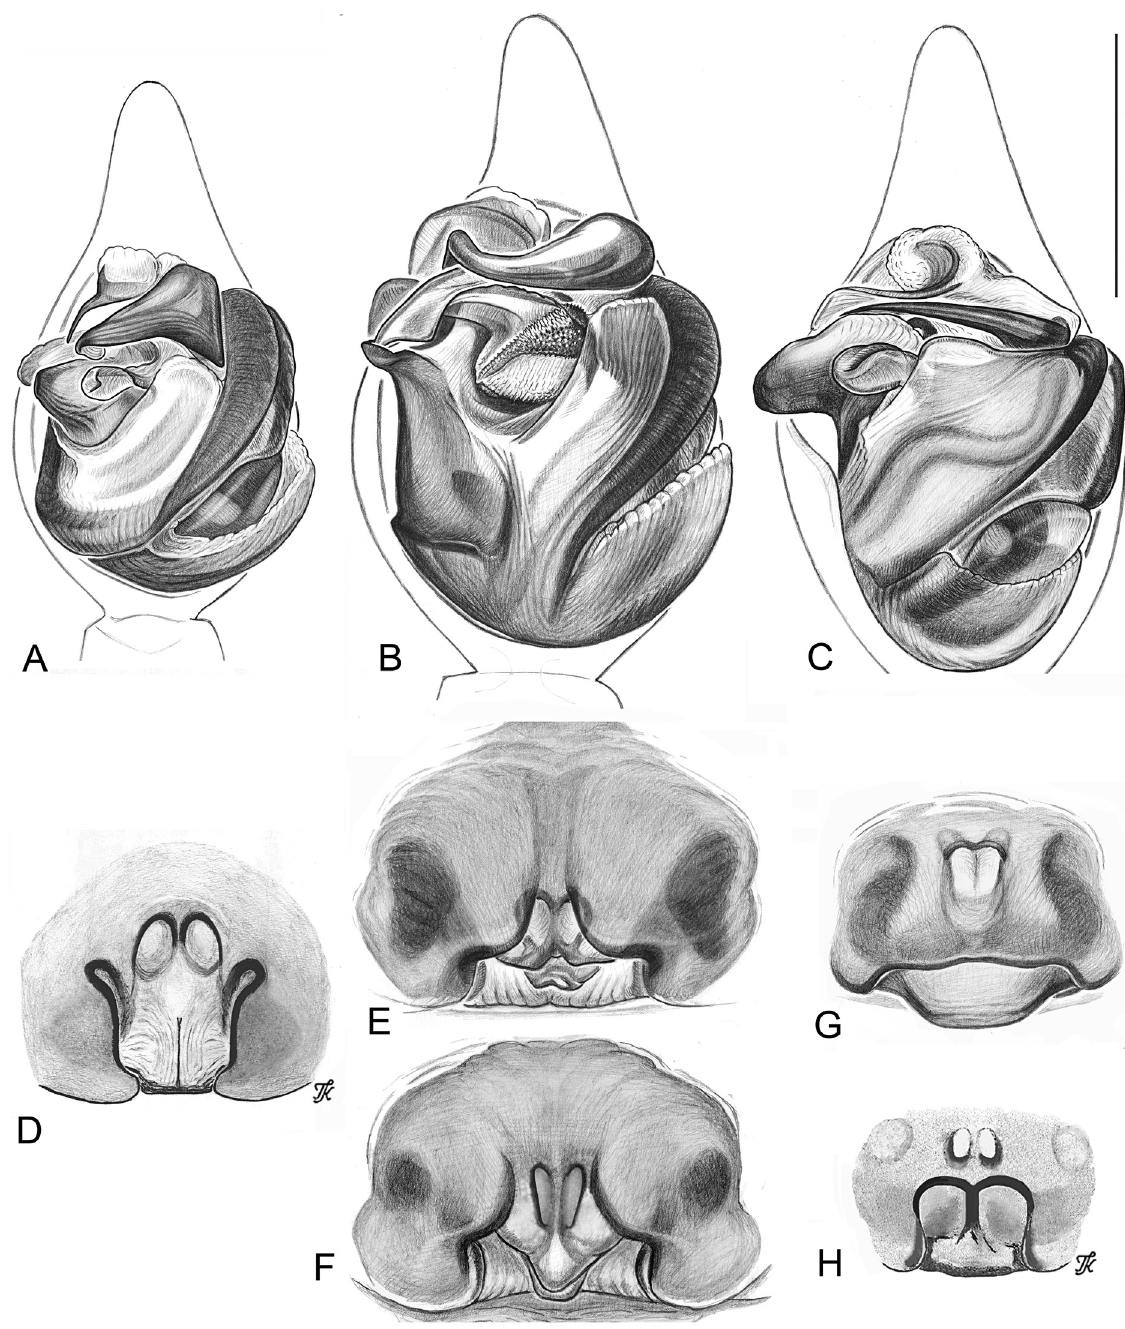
Fig. 3. Right male palp, ventral view (A–C) and epigyne (D– H). — A , D . Wadicosa benadira (Capo- riacco) (A from Kenya, WNW of Mombasa; D from Kenya, Marsabit). — B , E . W. cognata sp. nov. B . Holotype. E . Paratype. — C , G . W. jocquei sp. nov. C . Holotype. G . Allotype. — F . W. fidelis (Pickard-Cambridge) from Spain. — H . W. russellsmithi sp. nov., holotype. Scale bar: A–H = 0.5